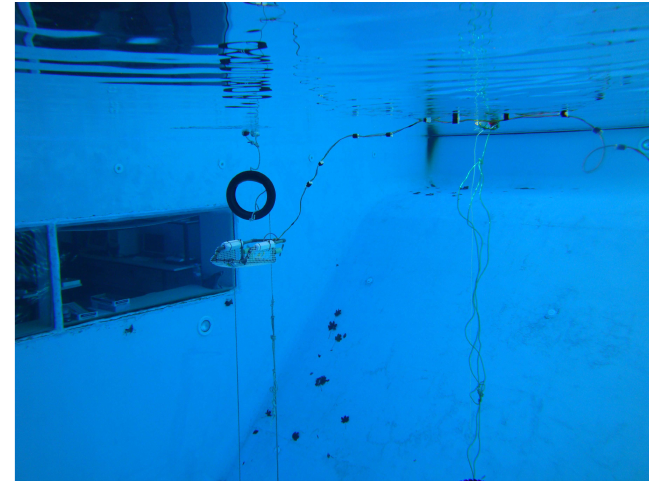
Figure 12. The vehicle and the mission